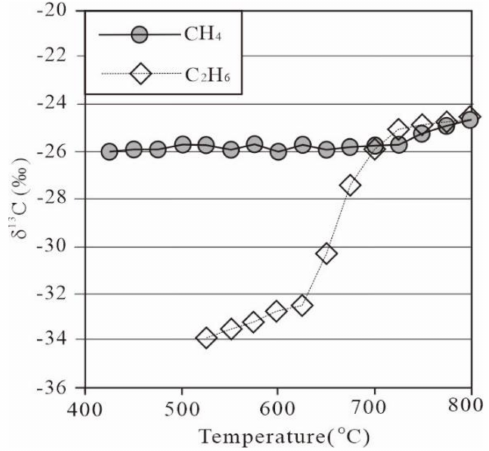
Figure 4. Variations of δ 13 C 1 and δ 13 C 2 with increasing